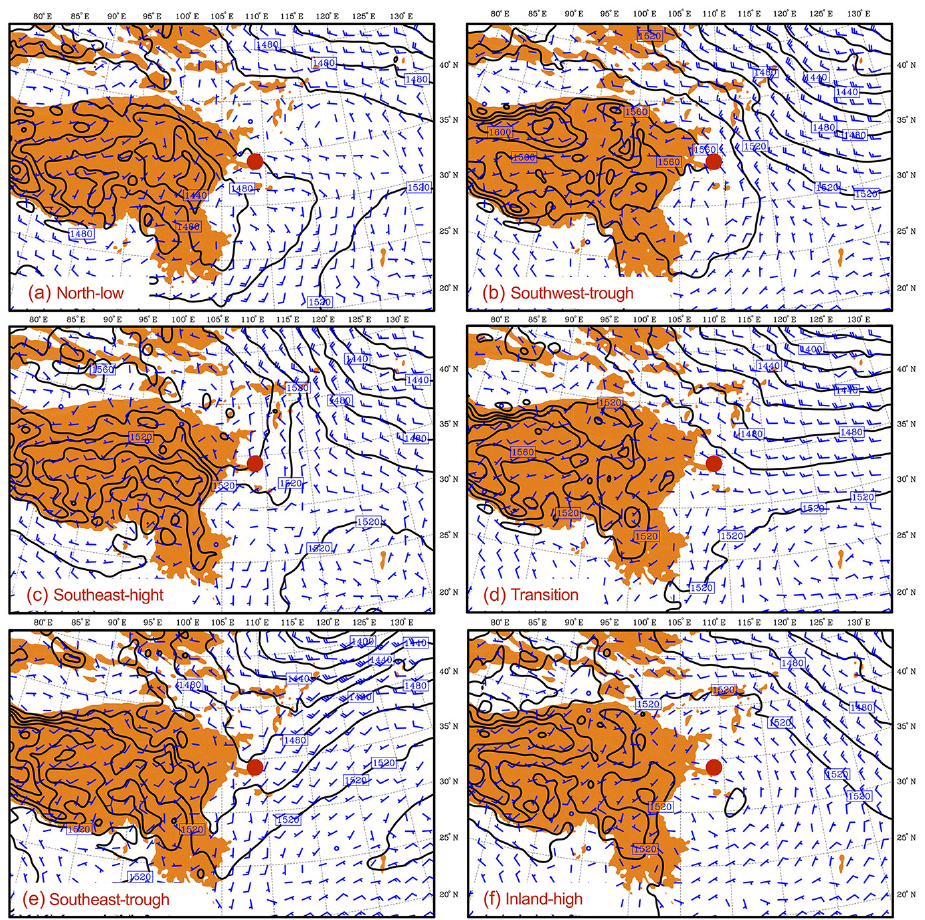
Figure 2. Composite distributions of winds and geopotential heights on 850hPa at 08:00BJT for the categories of (a) “north-low”, (b) “southwest-trough”, (c) “southeast-high”, (d) “transition”, (e) “southeast-trough”, and (f) “inland-high”. The red filled circle is Xi’an. The orange shading represents the terrain height over